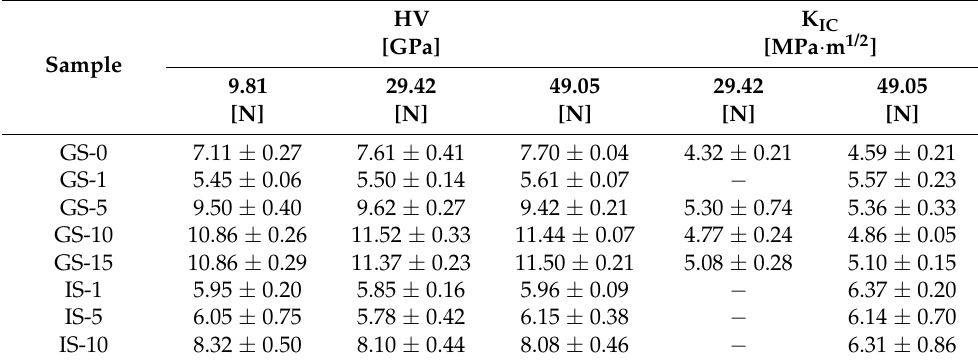
Table 6. Vickers hardness values (HV) for loads of 9.81, 29.42 and 49.05 N as well as the critical stress intensity factors (K IC ) for loads of 29.42 and 49.05 N, as measured for the investigated sinters obtained via 2 h of thermal treatment in air at 1773